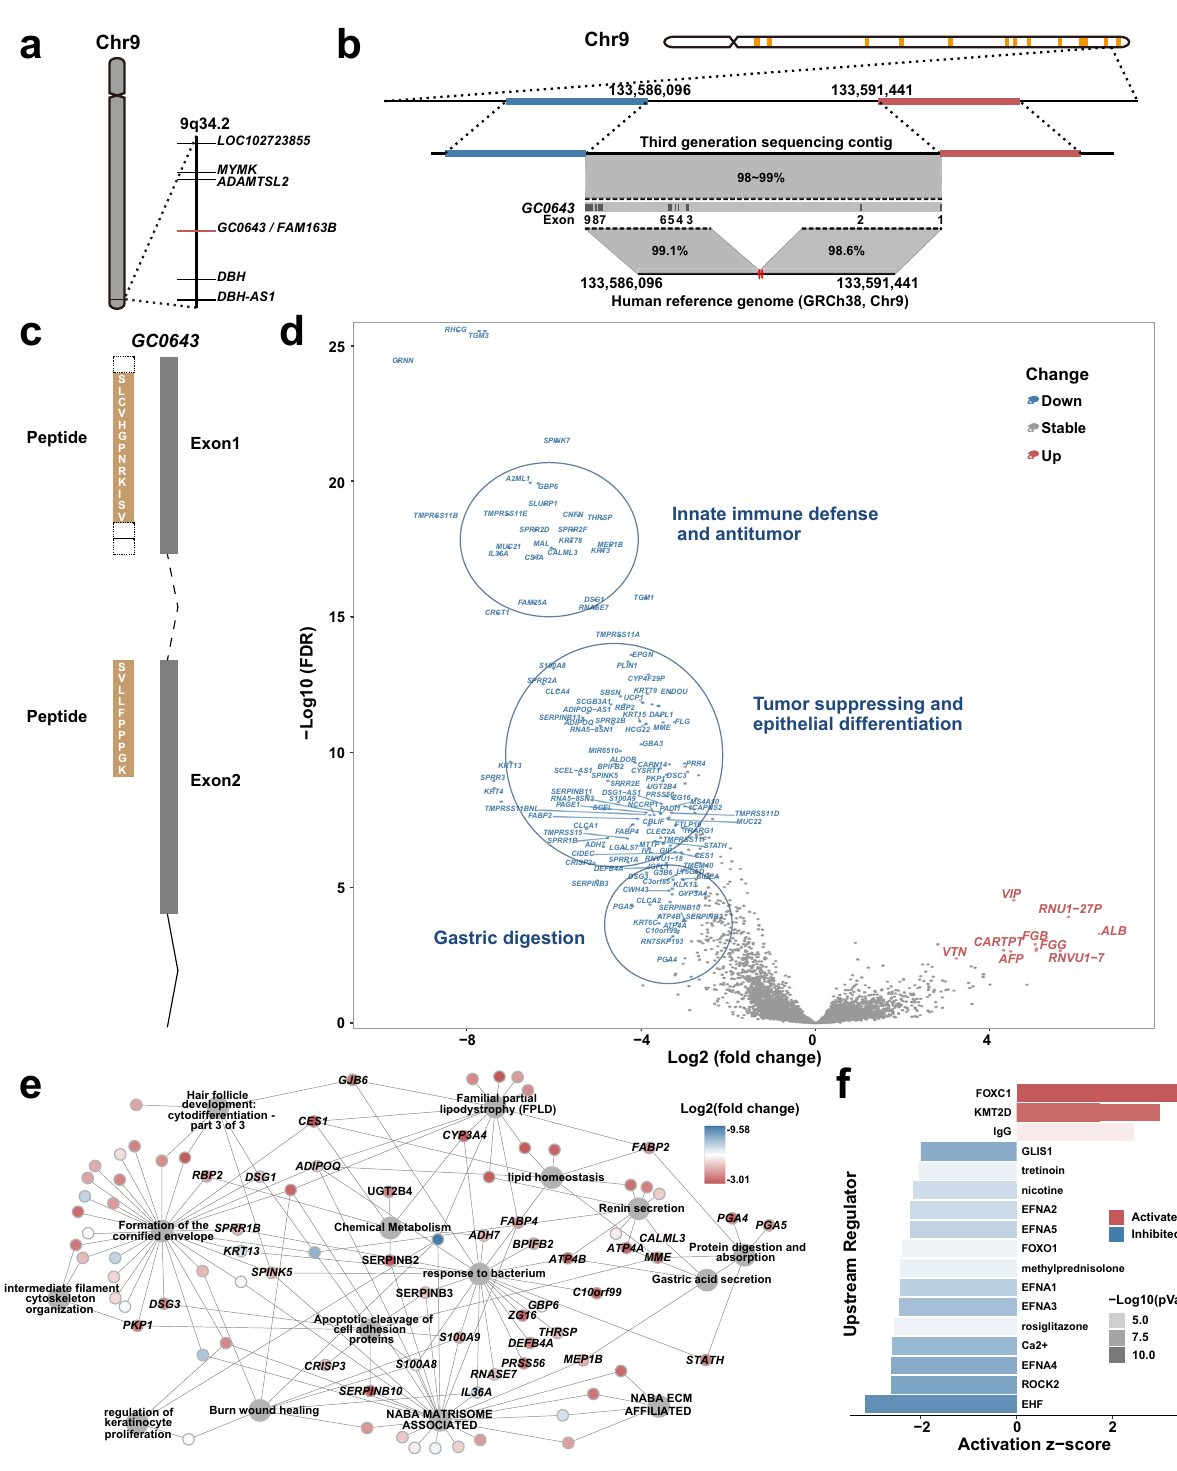
Fig. 5 | Chromosome location and functional enrichment of gene GC0643 . a GC0643 gene is localized on 9q34.2 by long-read sequencing analysis against GRCh38.Theneighboringgenesof GC0643 arealsopresented. b Thecorrelationof GC0643 position with the SV breakpoints. Four long-read sequencing contigs support the chromosomal location of GC0643 , and one of them is shown in the fi gure.The third-generation sequencing datarevealthata fragment of ~1700bpsis missinginGRCh38.SVanalysisshowstwoSVbreakpointsintheregion(thetwored dots between chr9:133,588,624 and chr9:133,588,681 shown on the bottom black line). c The mapping of GC0643 and a peptide sequence derived from CPTAC